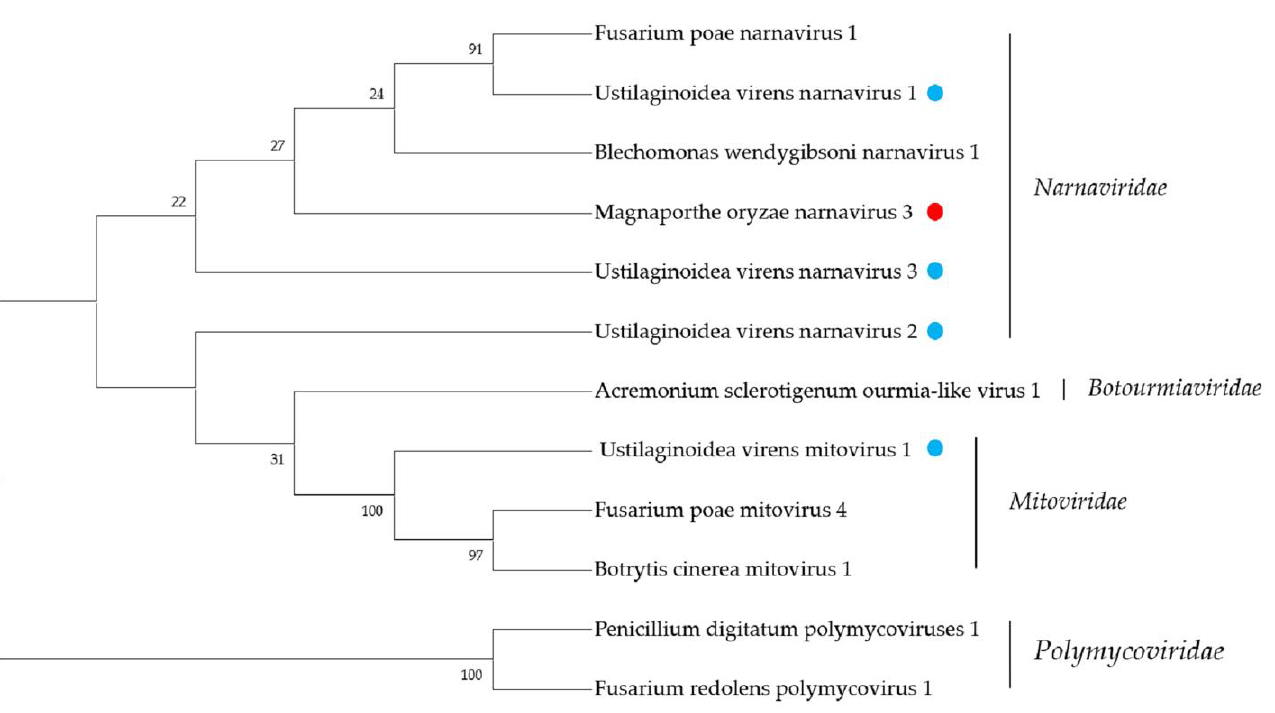
Figure 4. Phylogenetic analysis of viruses in the families Narnaviridae and Mitoviridae . Neighbor- joining-method phylogenetic tree based on the core RdRP motifs of putative viruses in the families Narnaviridae and Mitoviridae , other related viruses, and representatives of the two families. Viruses marked with red color are found in P. oryzae and blue color in U. virens . The viruses without a color annotation are the representatives of the known species of each viral family.